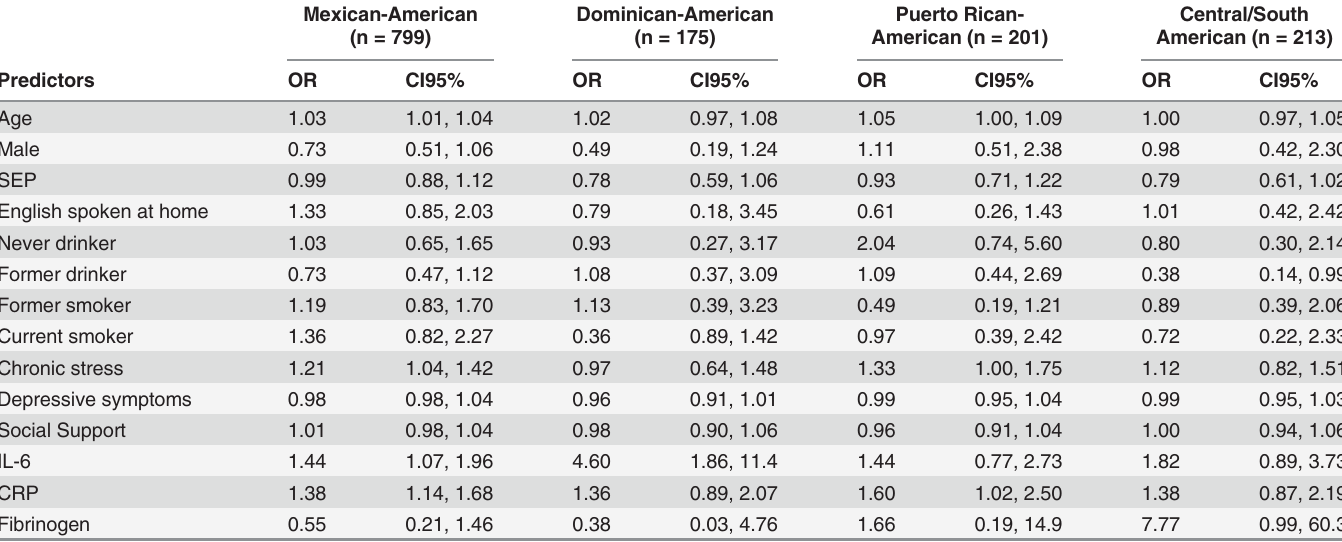
Table 3. Fully adjusted model for each national